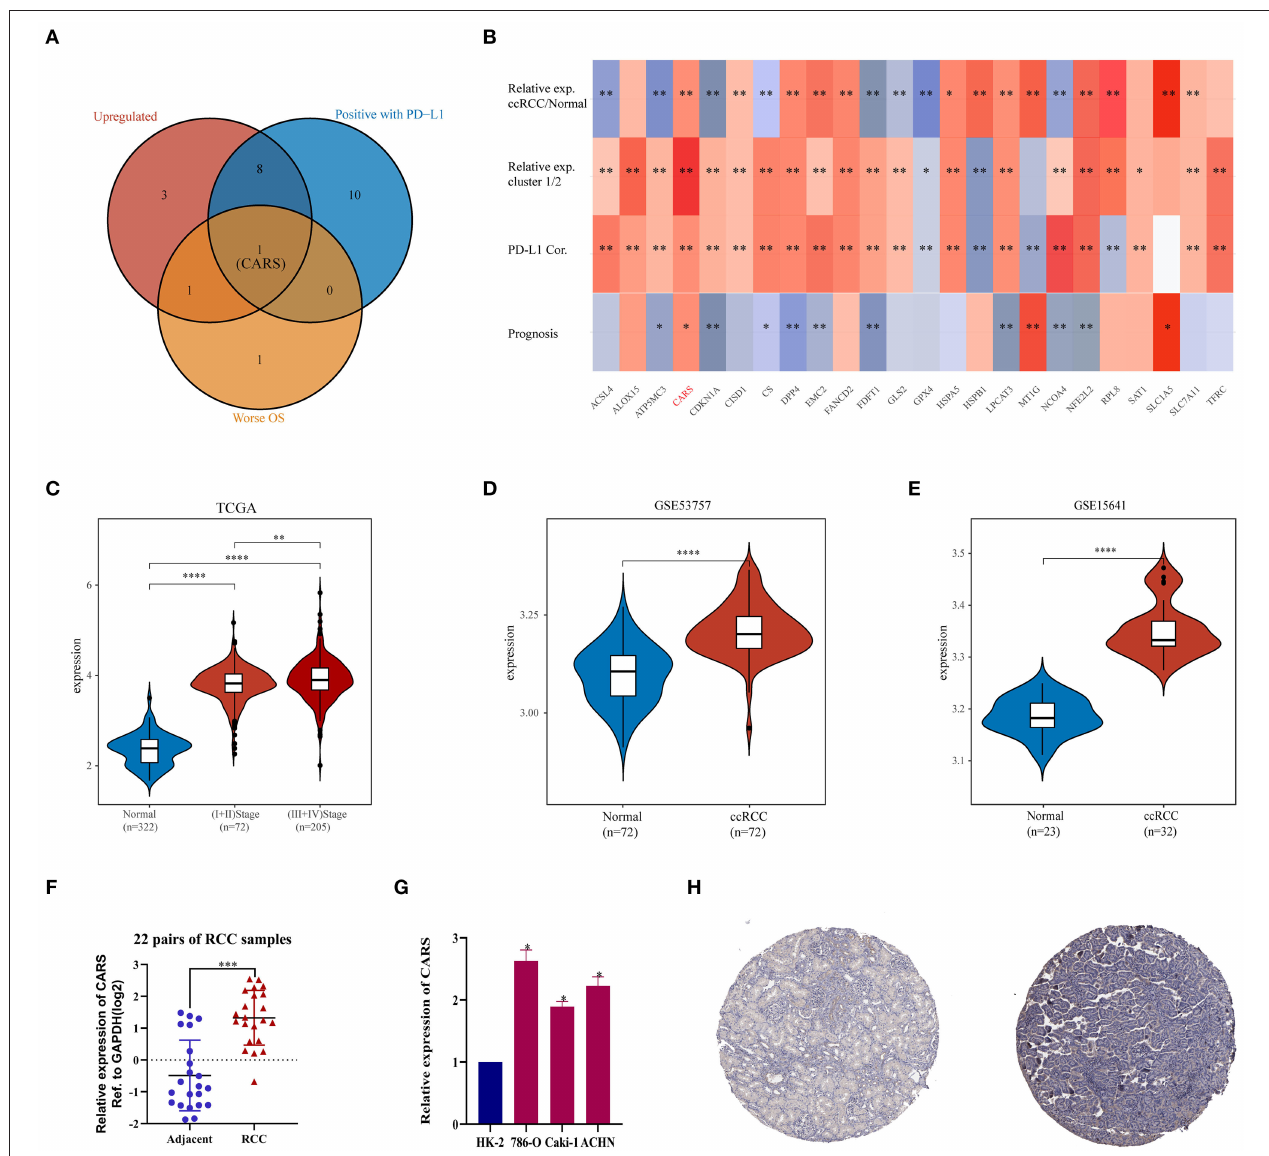
FIGURE 5 | Analysis of the CARS gene expression in ccRCC. (A) The Venn diagram suggested that the upregulation of CARS was an unfavorable prognostic factor and positively correlated with the PD-L1 expression in clear cell renal cell carcinoma (ccRCC). (B) The heat map visualized the relative expression of 24 ferroptosis regulators in ccRCC/normal (row 1) and cluster 1/2 (row 2) and the correlations of 24 regulators with the PD-L1 expression (row 3) and prognosis (row 4). The red color indicates a high expression in ccRCC or cluster 1, positively correlated with PD-L1 or bad prognosis. * p < 0.05 and ** p < 0.01. (C) CARS was upregulated in ccRCC tissues compared to normal tissues, and the expression significantly correlated with AJCC stages. (D,E) Validation sets showed that CARS was highly expressed in ccRCC tissues compared to adjacent normal tissues in GSE53757 (D) and GSE156417 (E) . (F) Relative expression of CARS was detected by qRT-PCR in 22 pairs of ccRCC and normal tissues. (G) Compared with HK-2 cell line (normal), CARS was highly expressed in 786-O, ACHN, and caki-1 cell lines (ccRCC). (H) Immunohistochemistry staining indicated that, compared with normal kidney tissue (left), CARS was significantly elevated in ccRCC tissue (right) in the human protein atlas (antibody HPA002384, × 10). * p < 0.05, ** p < 0.01, *** p < 0.001, and **** p <